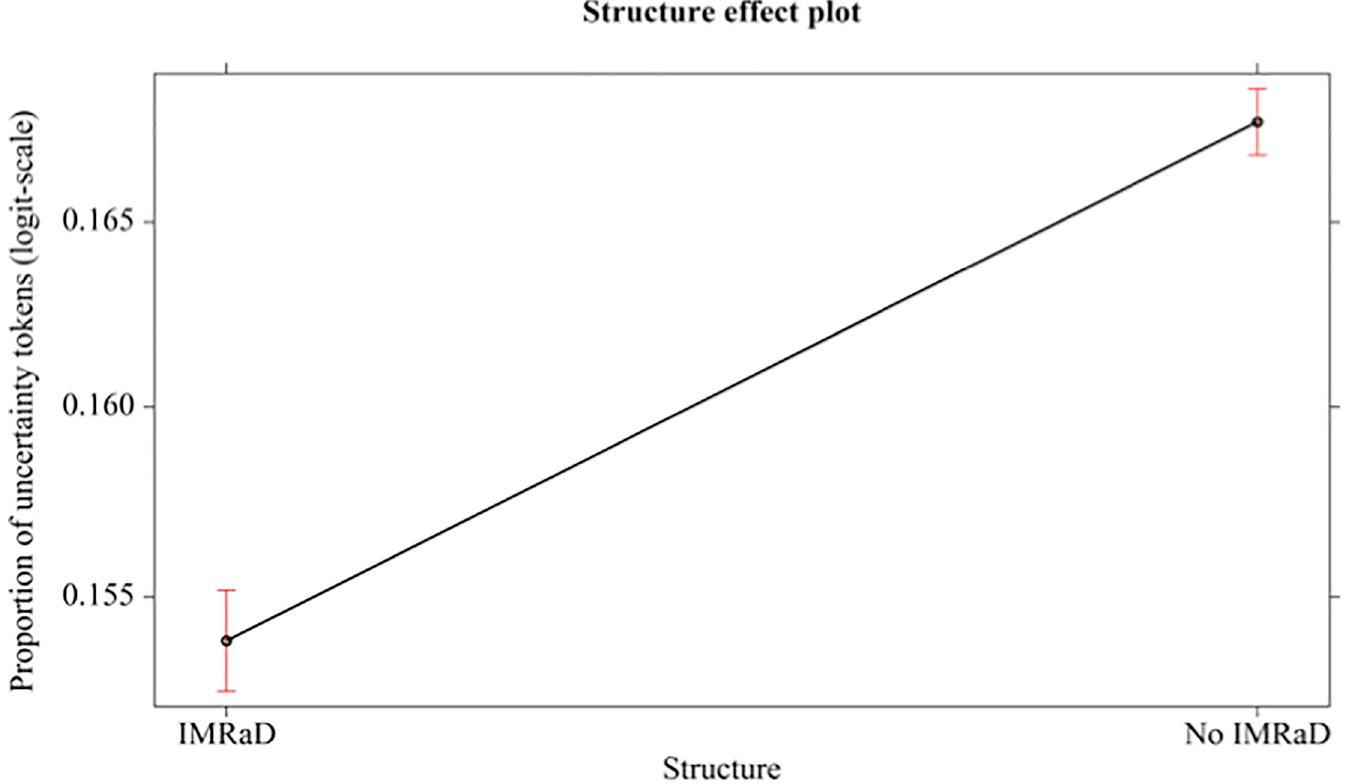
Fig 1. Mean proportions (95% confidence interval) of uncertainty tokens (in logit-scale) of different structure (IMRaD, no-IMRad, BMJ 1840–2007).